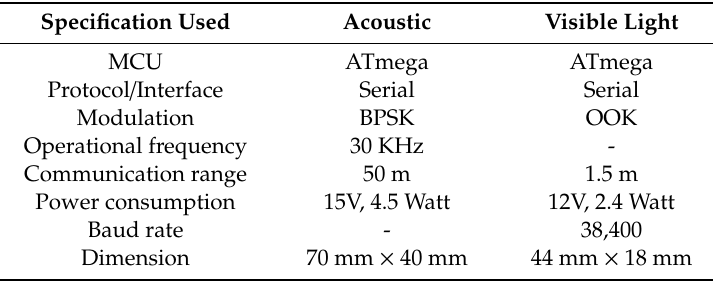
Figure 12 . Multi-media modem setup and operation. Table 4. Multi-media modem specifications. Table 4 . Multi-media modem specifications.